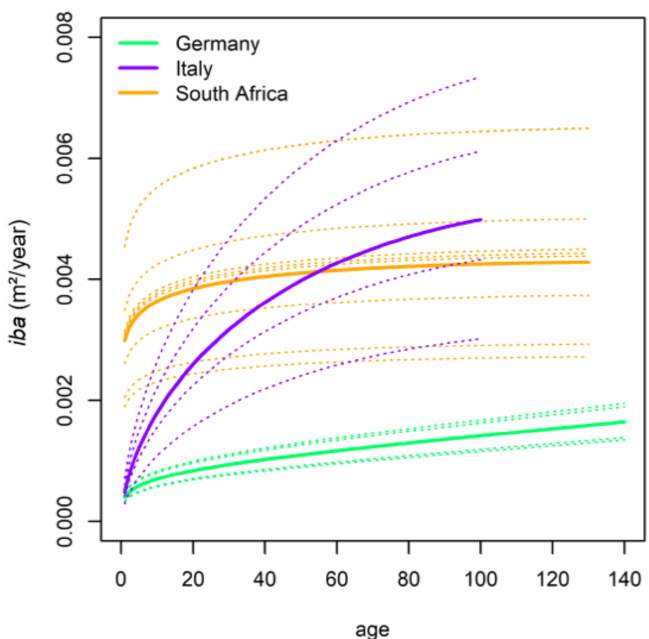
Figure 4. Growth level development comparing the three experiments, pictured as the mean individual tree basal area increment over the age of the sampled trees. The solid lines represent the experiments and the dotted lines the regions within the experiments, respectively. iba : individual tree basal area